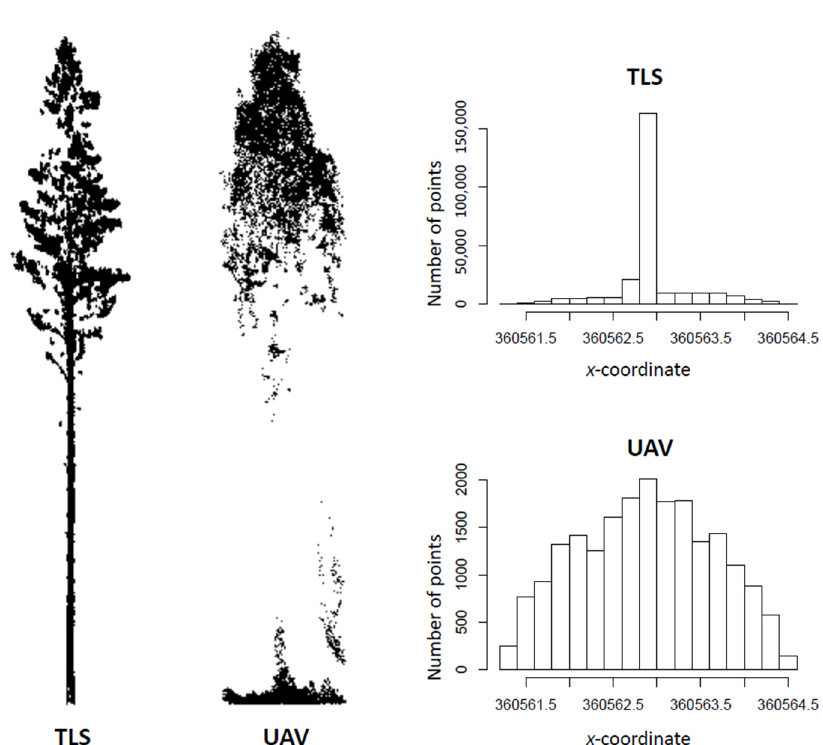
Figure 7. Terrestrial laser scanning (TLS, left ) and unmanned aerial vehicle (UAV, right ) measured point clouds of an example, Scot’s pine tree. For this tree, TLS measured 260,000 points and UAV 20,000. The histograms (TLS top , UAV bottom ) illustrate the number and distribution of the points with respect to the x -coordinate.